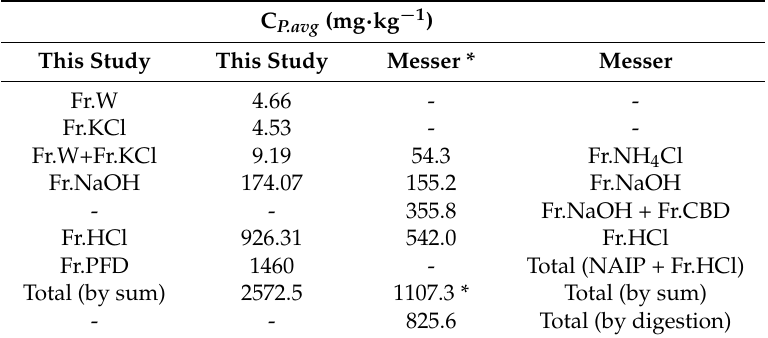
Table 6. Fractionation results from current and previous studies by Messer, Hardy and Ihnat [34]. The previous study reports the sum of Fr.NaOH and Fr.CBD as non-apatite inorganic-P